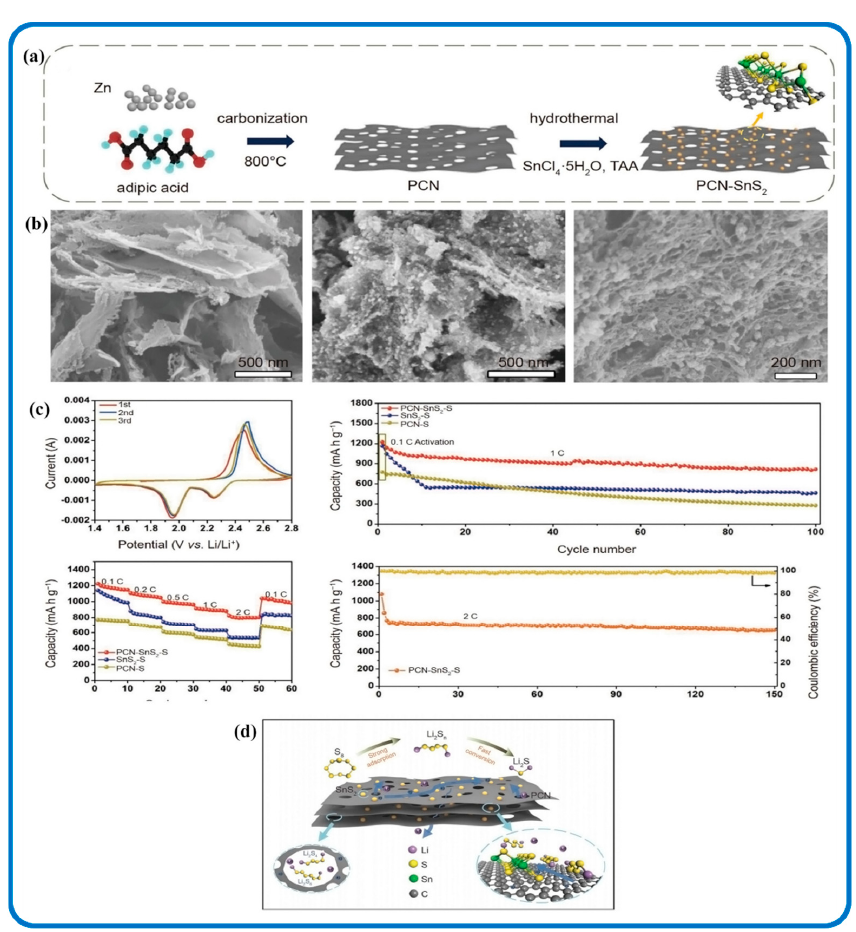
Figure 17. ( a ) Schematic preparation of PCN-SnS 2 composites, ( b ) SEM images of porous carbon nanosheets (PCN) and PCN-SnS 2 , ( c ) overall lithium-sulfur battery performance of PCN-SnS 2 nanocomposite, and ( d ) schematics of the conversion process of sulfur on PCNs-SnS 2 . Adapted with permission from Springer Nature [237]. Copyright 2021.